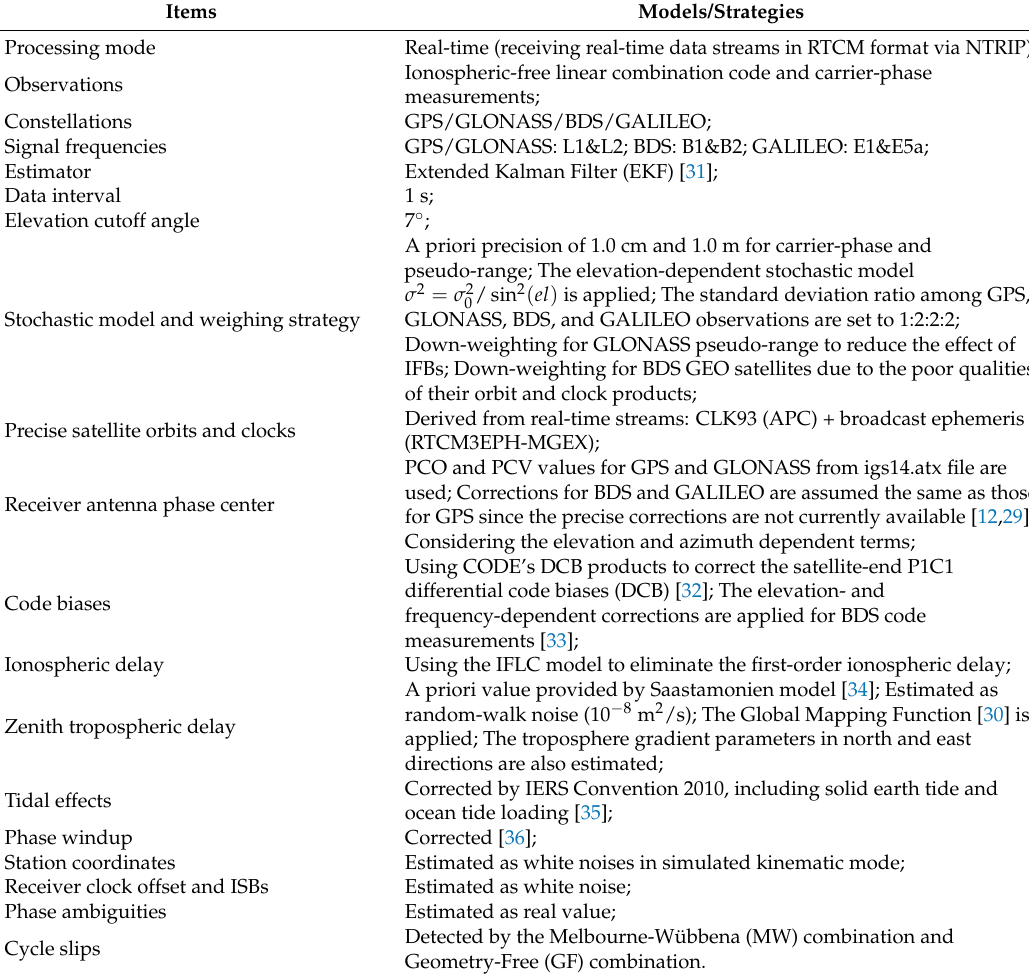
Table 2. Data processing strategies and settings for real-time multi-GNSS